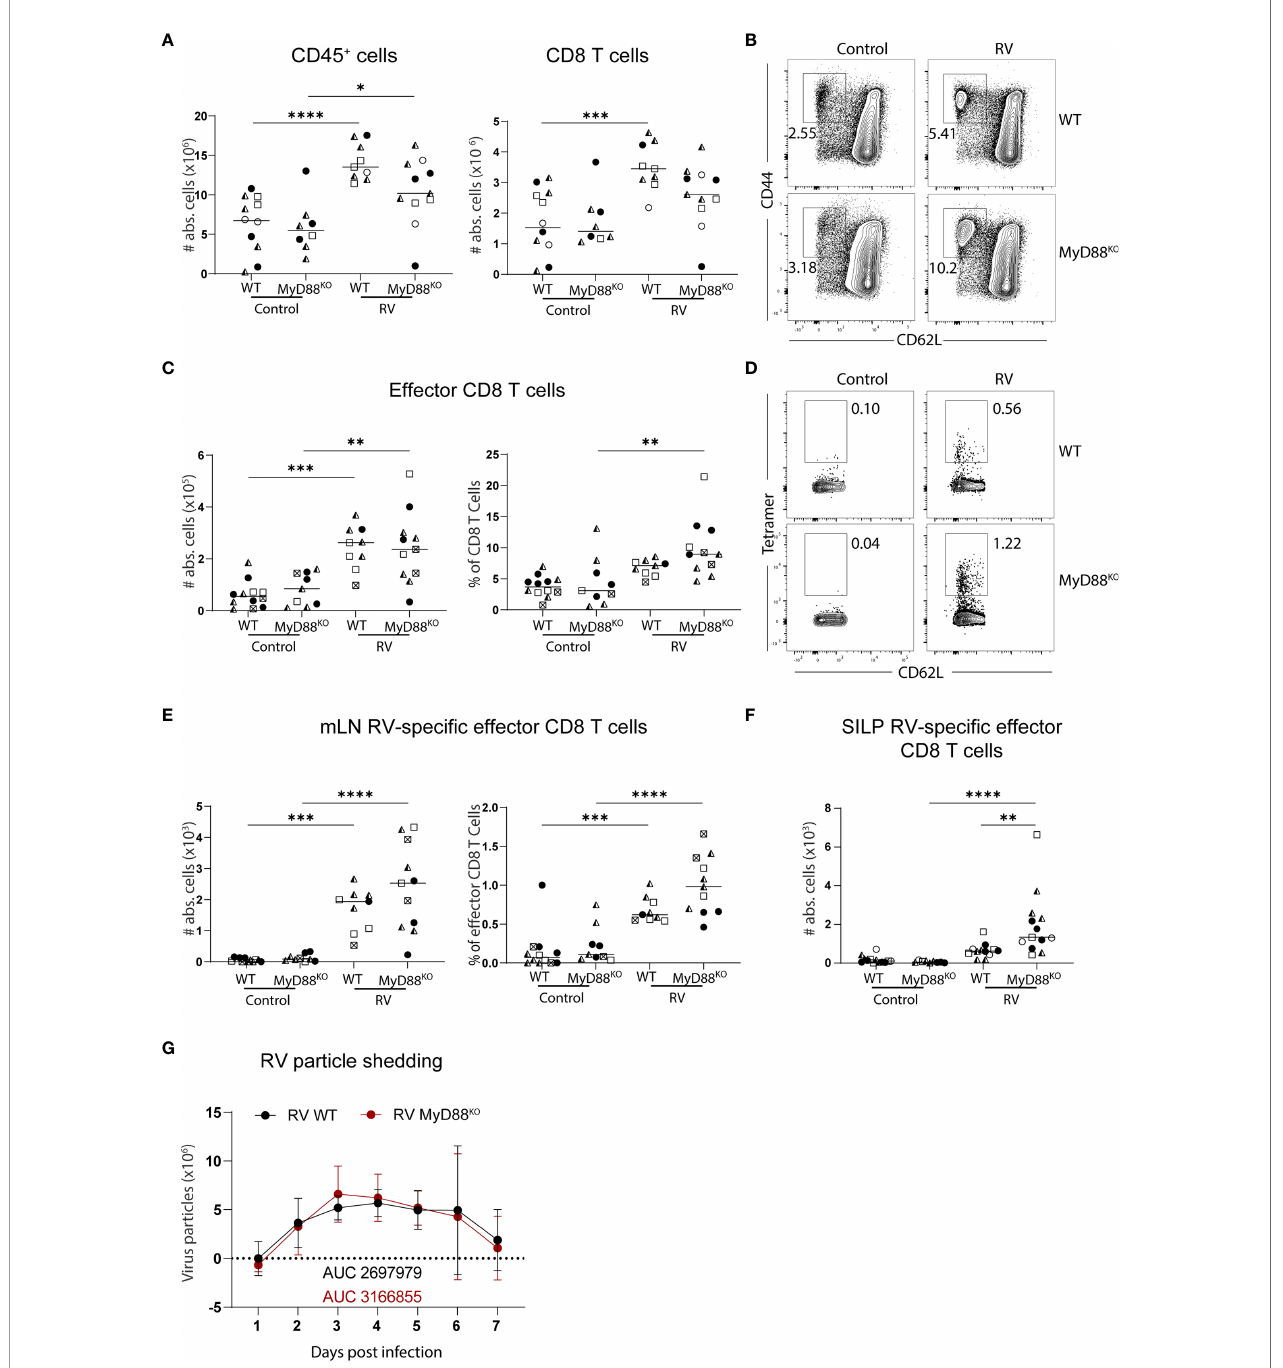
FIGURE 2 | Lack of MyD88 signalling does not impact on the generation of the RV-speci fi c CD8 T cell response. WT and MyD88 KO mice were infected with RV. (A-E, G) MLN cells and (F) SILP cells isolated from uninfected control and RV infected WT and MyD88 KO mice seven days post oral infection. (A) Total number of CD45 + cells and CD8 T cells (CD45 + CD3 + CD4 - CD8 a + ). (B) Representative FACS plot of effector CD8 T cells (CD62L - CD44 + ) pre-gated on CD45 + CD3 + CD4 - CD8 a + cells. (C) Absolute cell numbers and frequency of effector CD8 T cells (CD62L - CD44 + ). (D) Representative FACS plot of RV-speci fi c effector CD8 T cells (CD44 + CD62L - Tet + ). (E) Absolute cell numbers and frequency of RV-speci fi c effector CD8 T cells. (F) RV-speci fi c CD8 T cells (CD45 + CD3 + CD4 - CD8 a + CD44 + Tet + ). (G) Level of RV shedding measured by ELISA on fecal samples collected at indicated time points. Each data point represents one mouse from a total of four different experiments, indicated by the different symbols. Ordinary one-way ANOVA with Tukey´s multiple comparison test was performed for statistical analysis. *p < 0.05, **p < 0.01, ***p < 0.001, ****p <